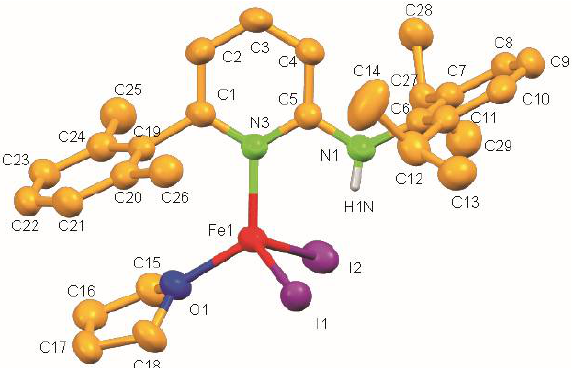
Figure 5. Molecular structure of 2 . Ellipsoids are set at 50% probability; hydrogen atoms except N-H are omitted for clarity.